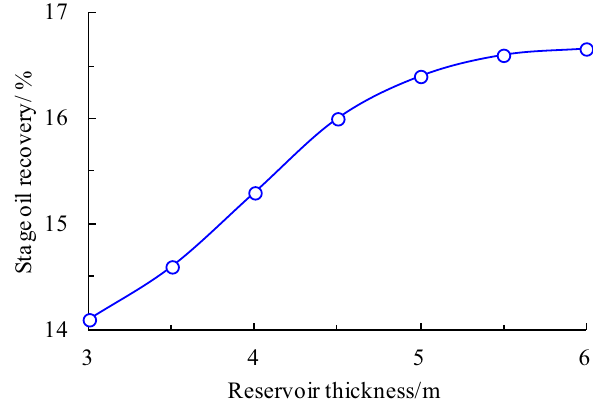
Fig. 6 Influence of reservoir